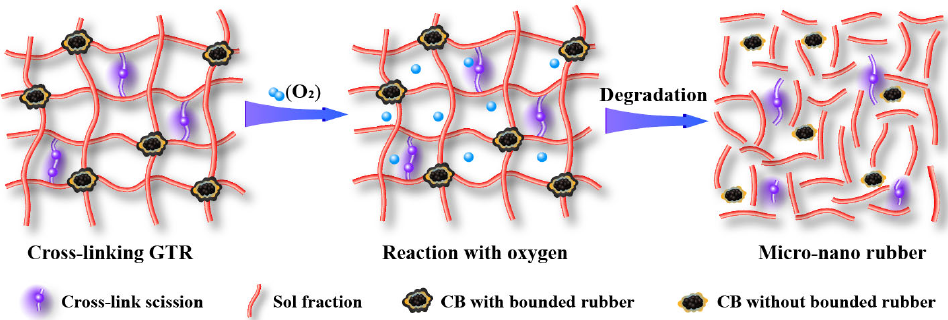
Figure 4. Schematic diagram of the dynamic thermal-oxidative reclaiming process [30]. The DR produced by the light pyrolysis process mainly consists of CB, sol